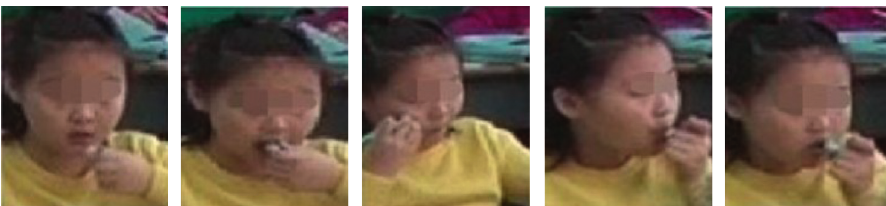
Figure 11: Example of student B abstracted status.